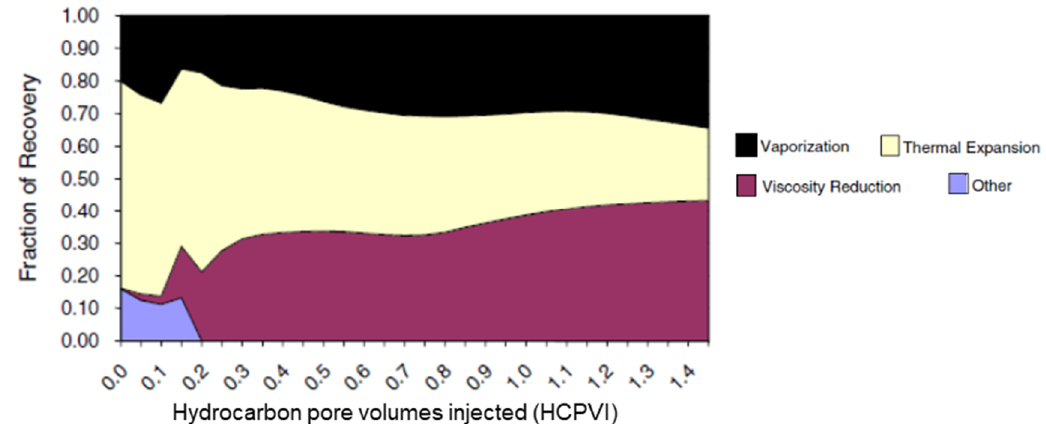
Figure 2. Relative importance of mechanisms contributing to incremental oil recovery for steamflood over waterflood reprinted by permission [23] Taylor & Francis Ltd, http: // www.tandfonline.com.